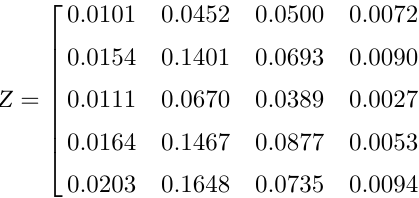
drawn from the weight of the first-level index that the reliability of TPGU is generally strong, so the reliability index is not used as the main evaluation index. The main focus is on the influ- ence of the cost indexes such as oil, electricity and coal consumption on the TPGU and the technical supervision indexes such as desulfurization and denitration. This is also in line with the practical requirements of high efficiency, stability, energy conservation and environmental